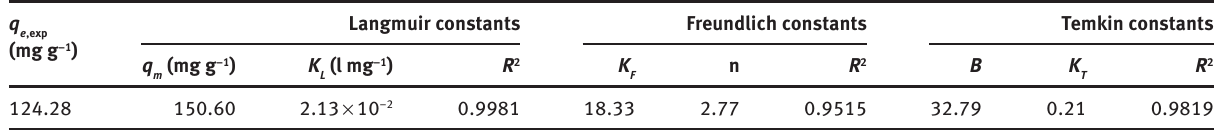
Table 2: Adsorption isotherm constants for MB adsorption. q e ,exp (mg g −1 )